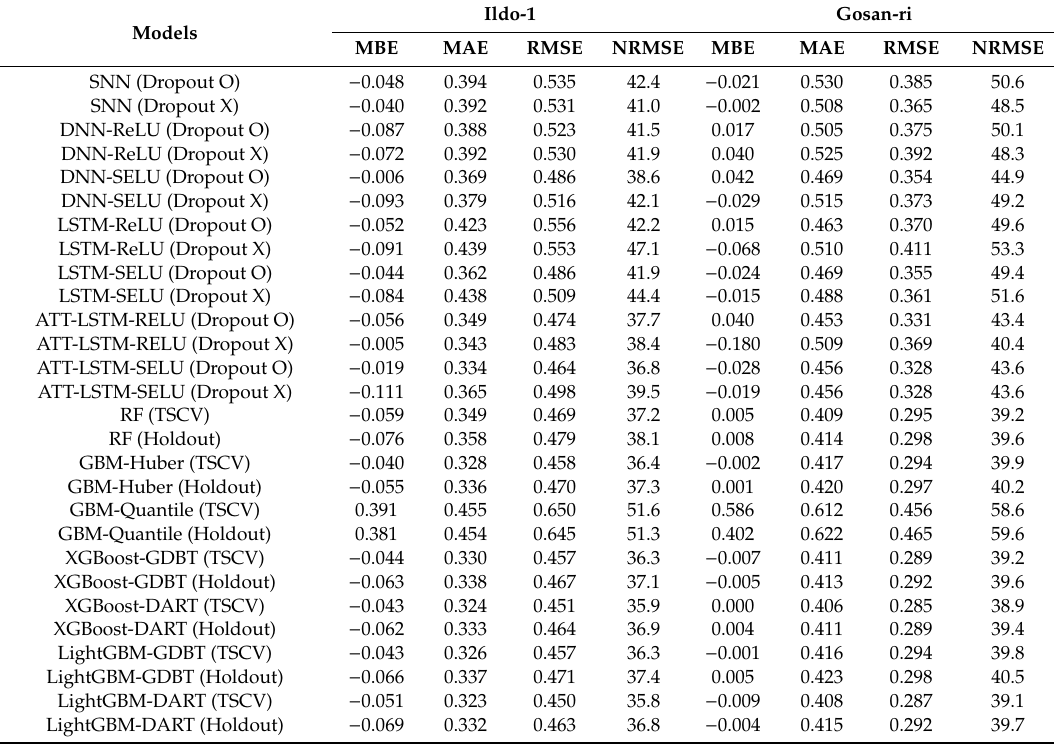
mean square error comparison according to the forecasting models.